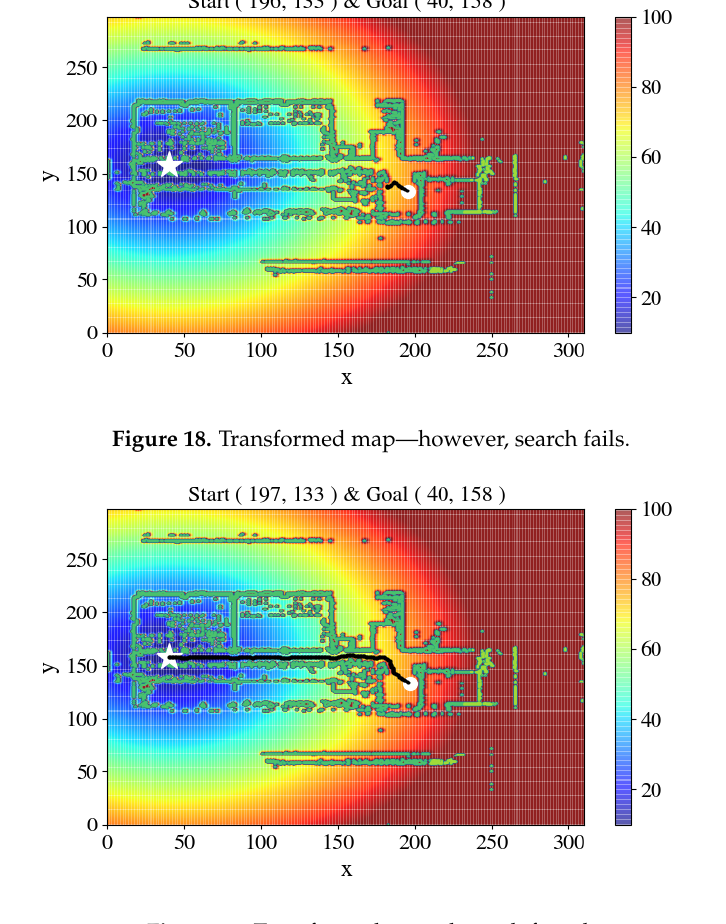
Figure 19. Transformed map, the path found.